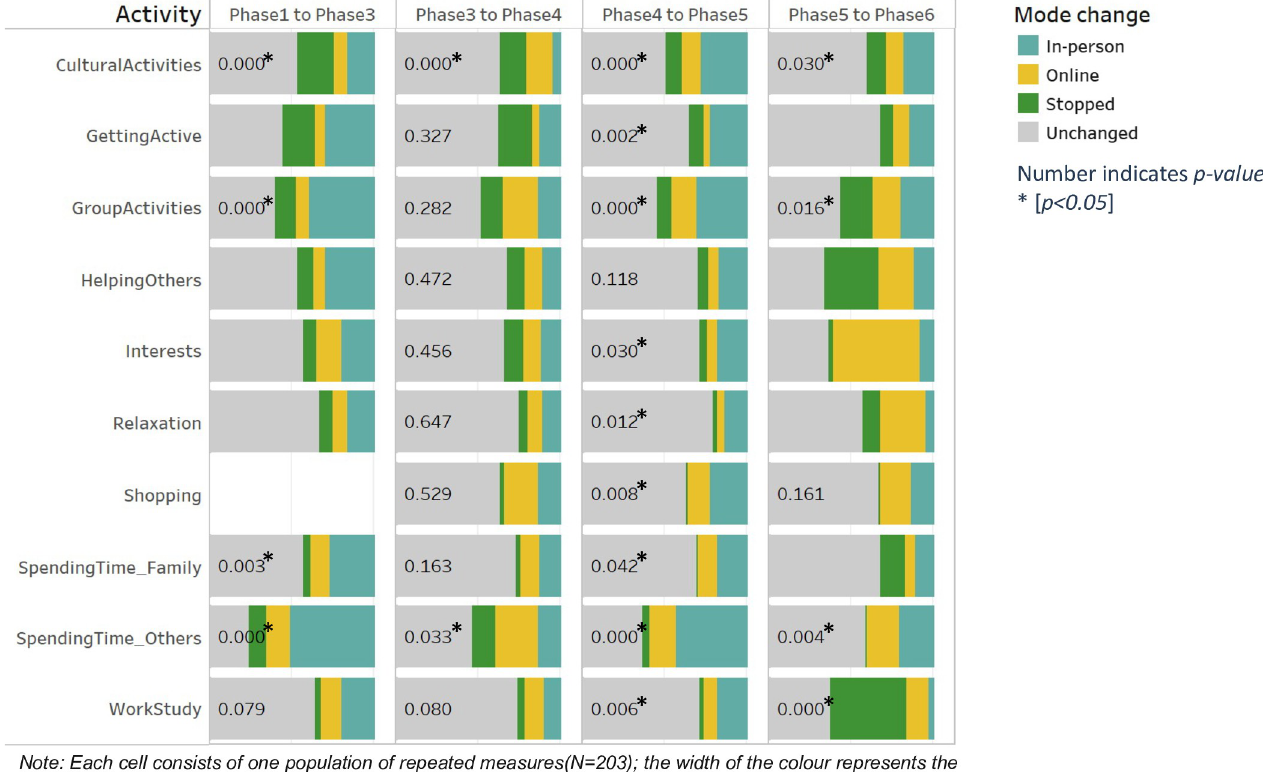
Fig 6. McNemar-Bowker test for mode change among the repeated measures; each cell represents the total repeated measures (N = 203); the width of the colour represents the proportion; phase 2 was excluded due to insufficient